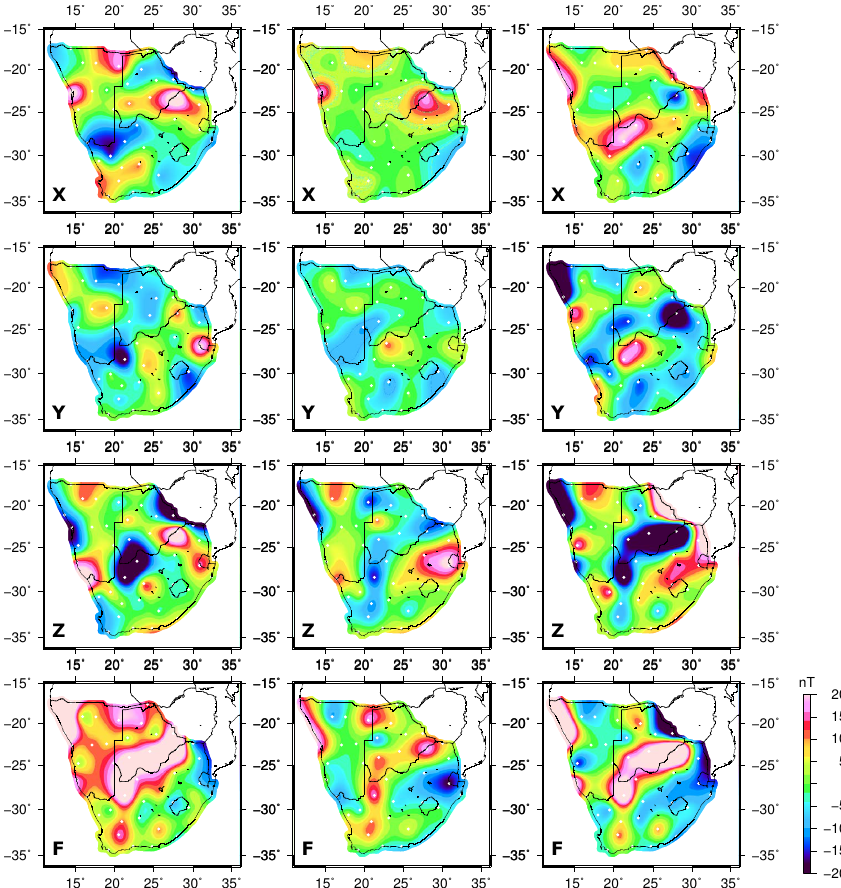
Figure 6. Estimates of lithospheric anomaly values at ground station locations, interpolated in the same way for a visual comparison (not reflecting the actual shape or dimension of anomalies). Orthogonal components based on the R-SCHA model and total field anomaly values from SaNaBoZi grid (left), predictions from EMM2010 model of SH degrees 15–720 (middle), and ground data processed as described in Sect. 2.1.1 (right). North ( X ), east ( Y ), vertical ( Z ), and total field ( F ) components from top to bottom and colour scale the same as in Fig.